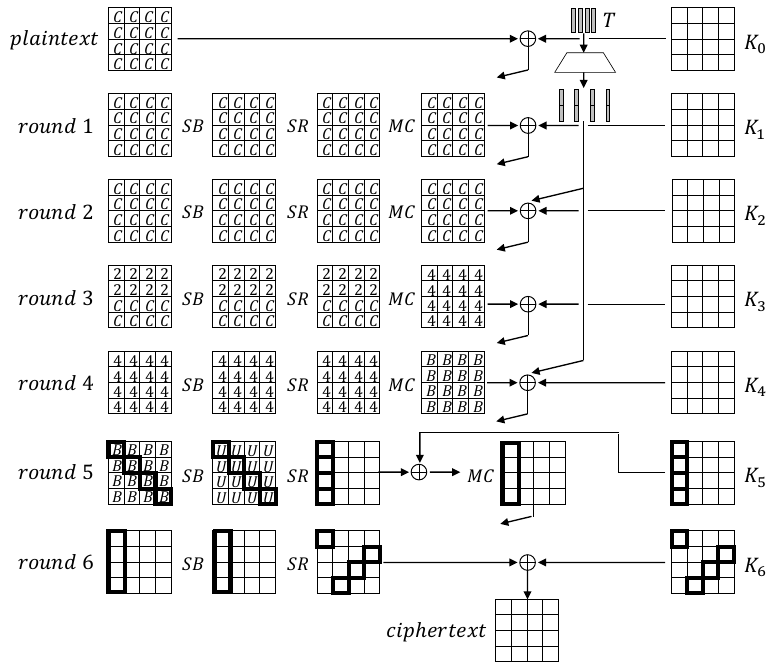
Figure 4: TweAES : Integral Distinguisher on TweAES via Tweak. ‘2’ represents that two kinds of values appear 8 times each and ‘4’ represents that four kinds of values appear 4 times each. By following the convention, ‘ B ’ and ‘ U ’ denote ‘balanced’ and ‘unknown’ properties,